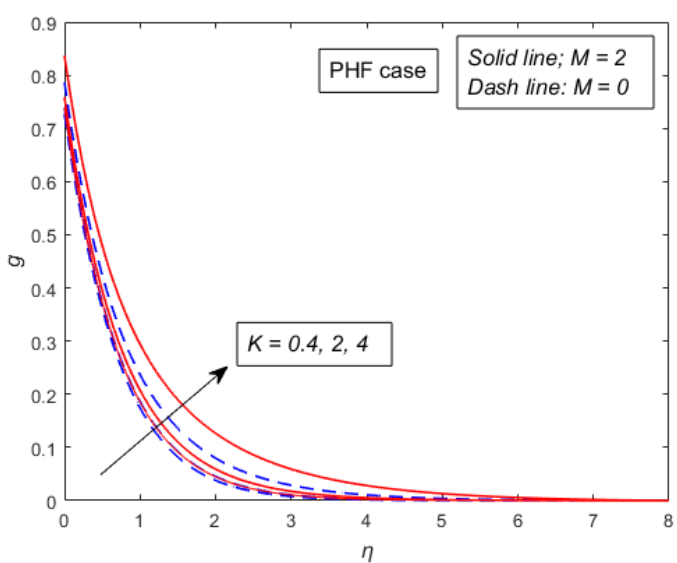
Figure 7. Variation of the temperature profile for different values of viscoelastic parameter K and magnetic parameter M for the PHF case when n = 3, Pr = 0.71, and Ec = 0.1.